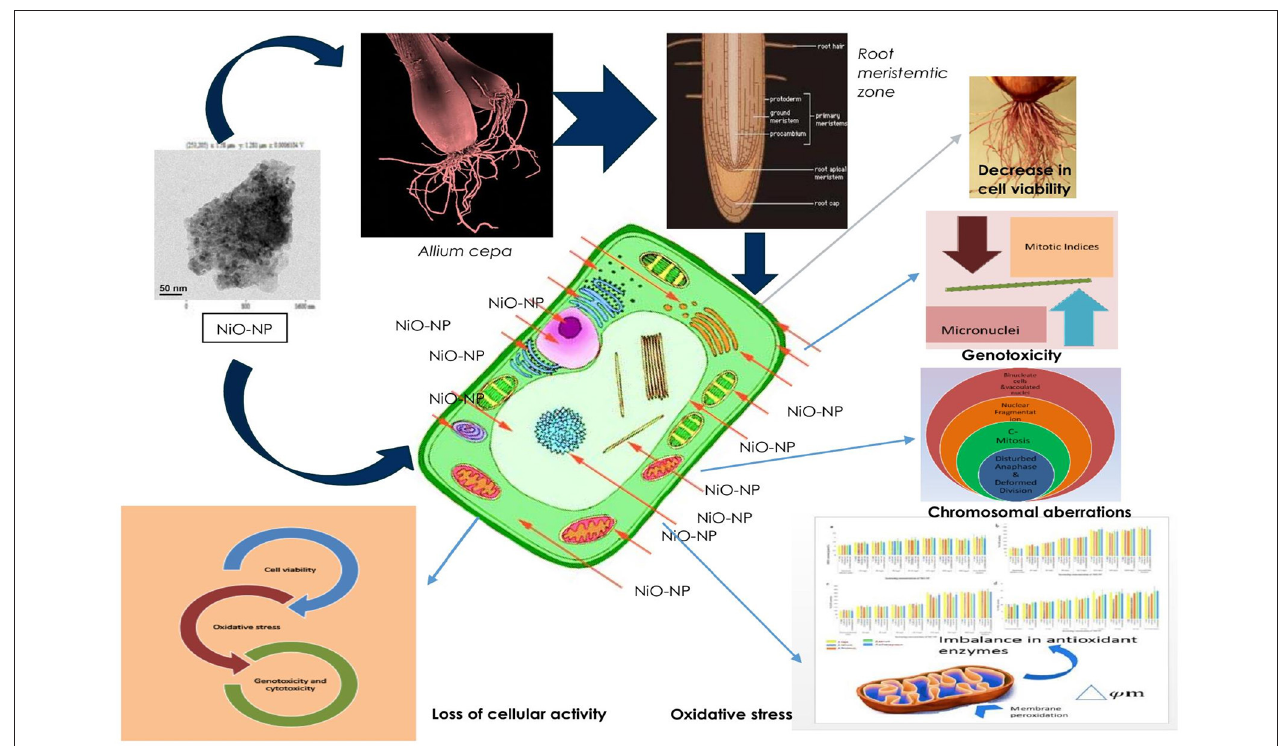
FIGURE 10 | Schematic presentation of possible mechanism of NiO-NP induced cytogenotoxicity in A. cepa